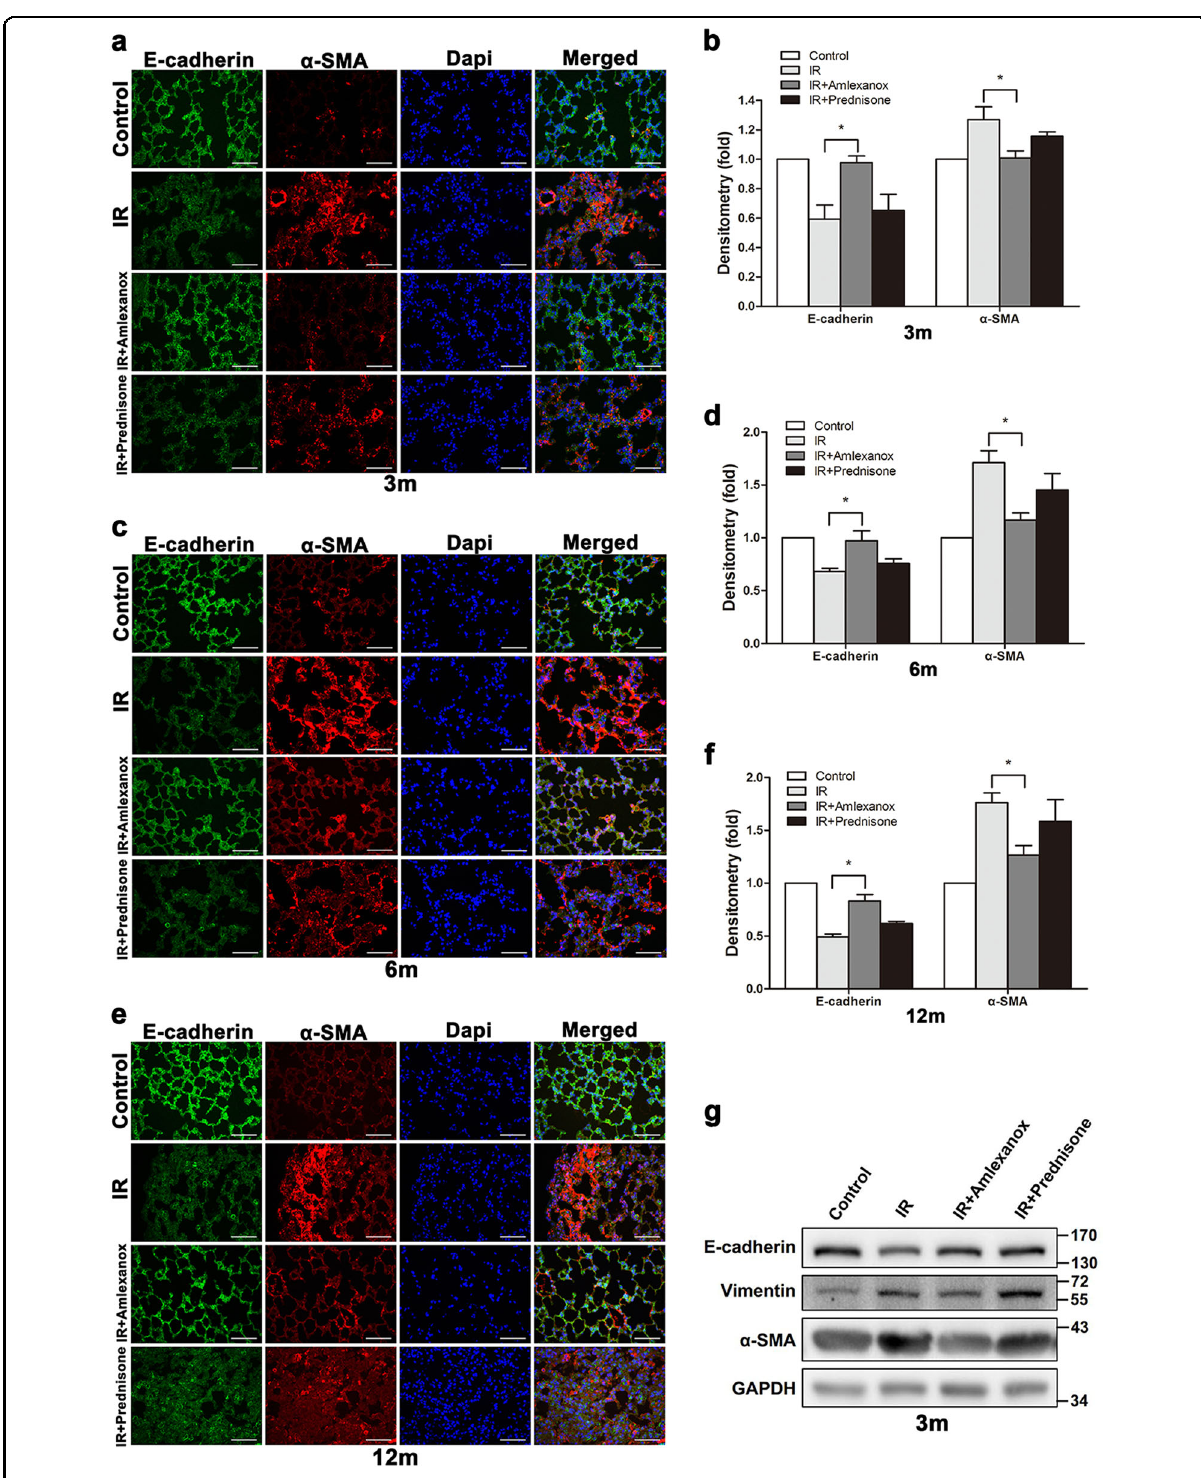
Fig. 8 Amlexanox inhibited EMT in lung tissues after irradiation. At 3, 6, and 12 months after irradiation, lung tissues were isolated, and stained for EMT-related markers, including E-cadherin and α -SMA ( a , c , e ); fl uorescence density was quanti fi ed in each group using software ( b , d , f ). * P < 0.05 and ** P < 0.01. Expression levels of the EMT markers E-cadherin, Vimentin, and α -SMA were con fi rmed by western blot assay at 3 ( g ), 6 ( h ), and 12 ( i ) months after irradiation. Cytokines, such as IL-4 ( j ) and IFN- γ ( k ), were measured in bronchoalveolar lavage fl uid (BALF) via ELISA 3 months after irradiation. ## P < 0.01 and # P < 0.05 vs. control group. * P < 0.05 vs. IR